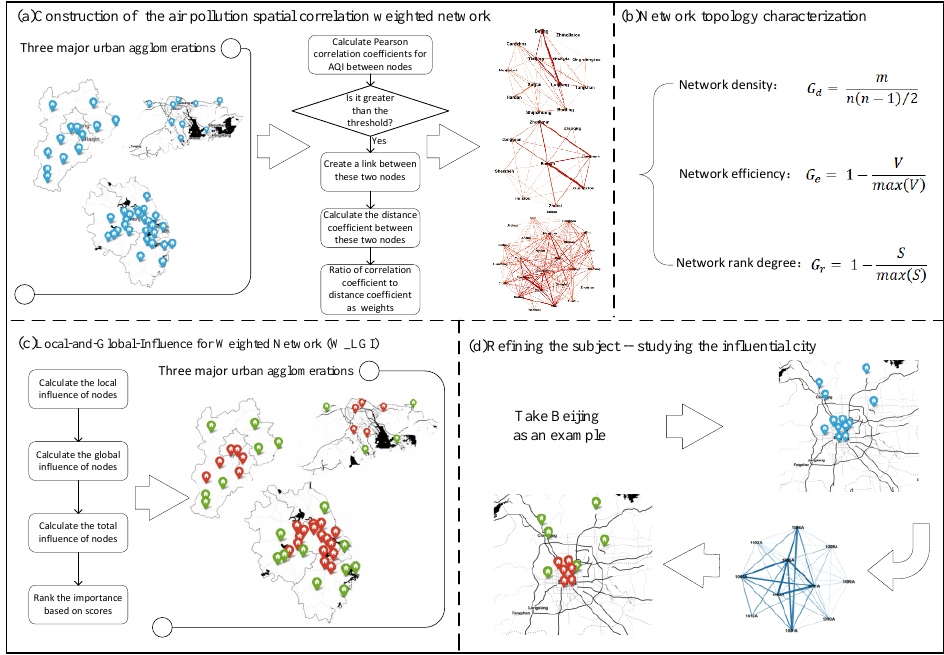
Figure 1. Flow chart of influential nodes identification method for air pollution spatial correlation weighted networks.